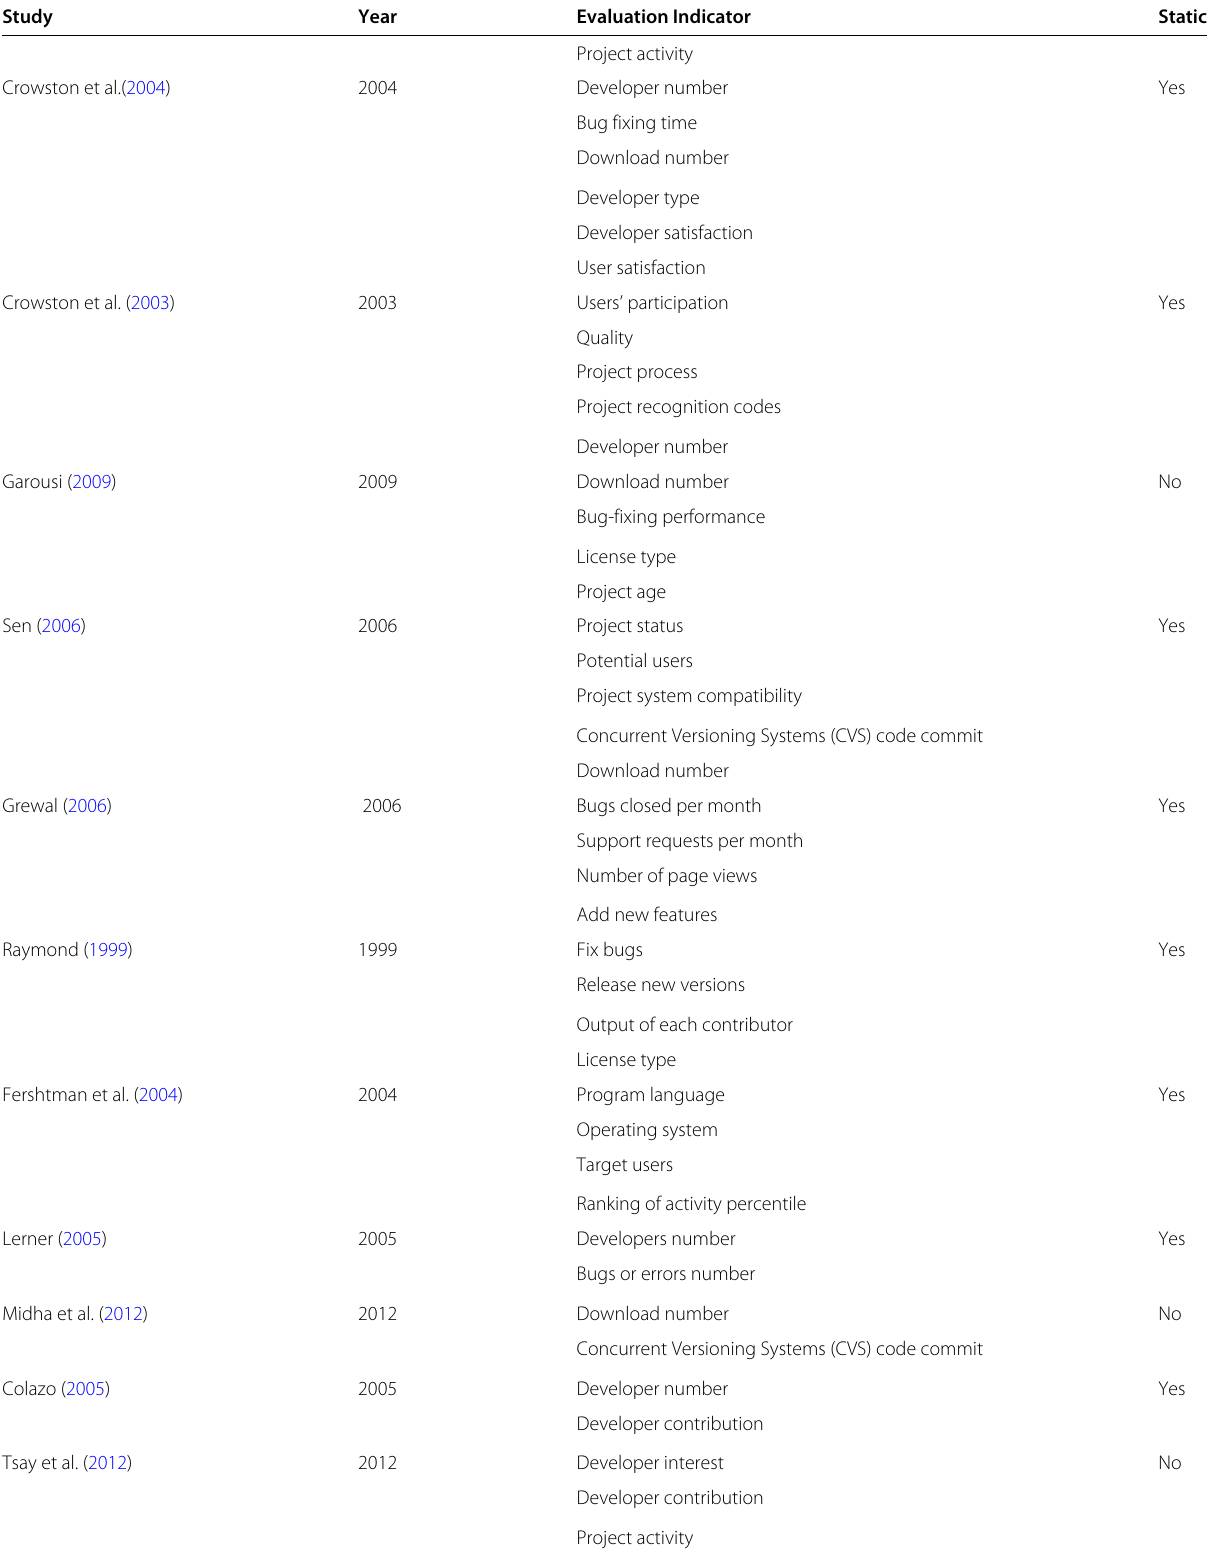
Table 2 OSS evaluation indicator proposed in the prior studies. “Evaluation Indicator” denotes the used evaluation indicators for investigation, “Static” indicates whether the authors used data at a single point to represent the whole